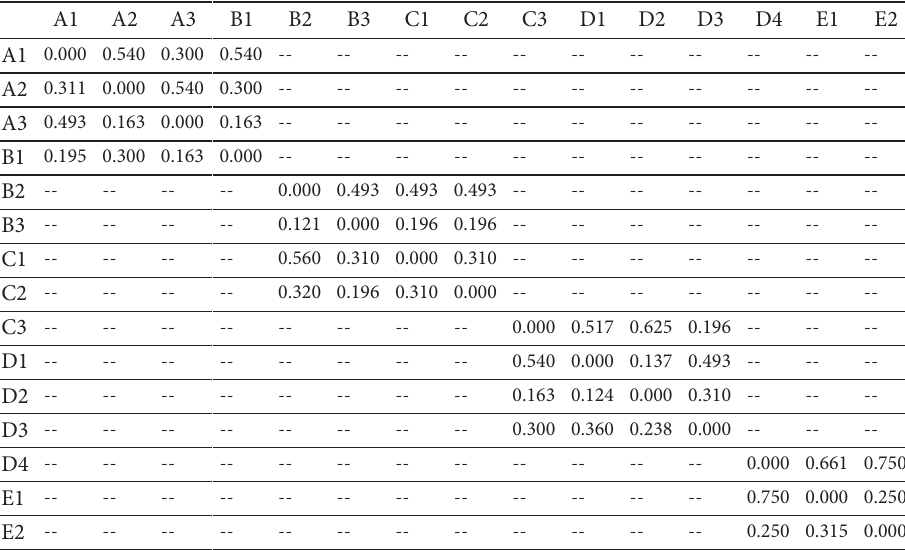
Table 4. The supermatrix before